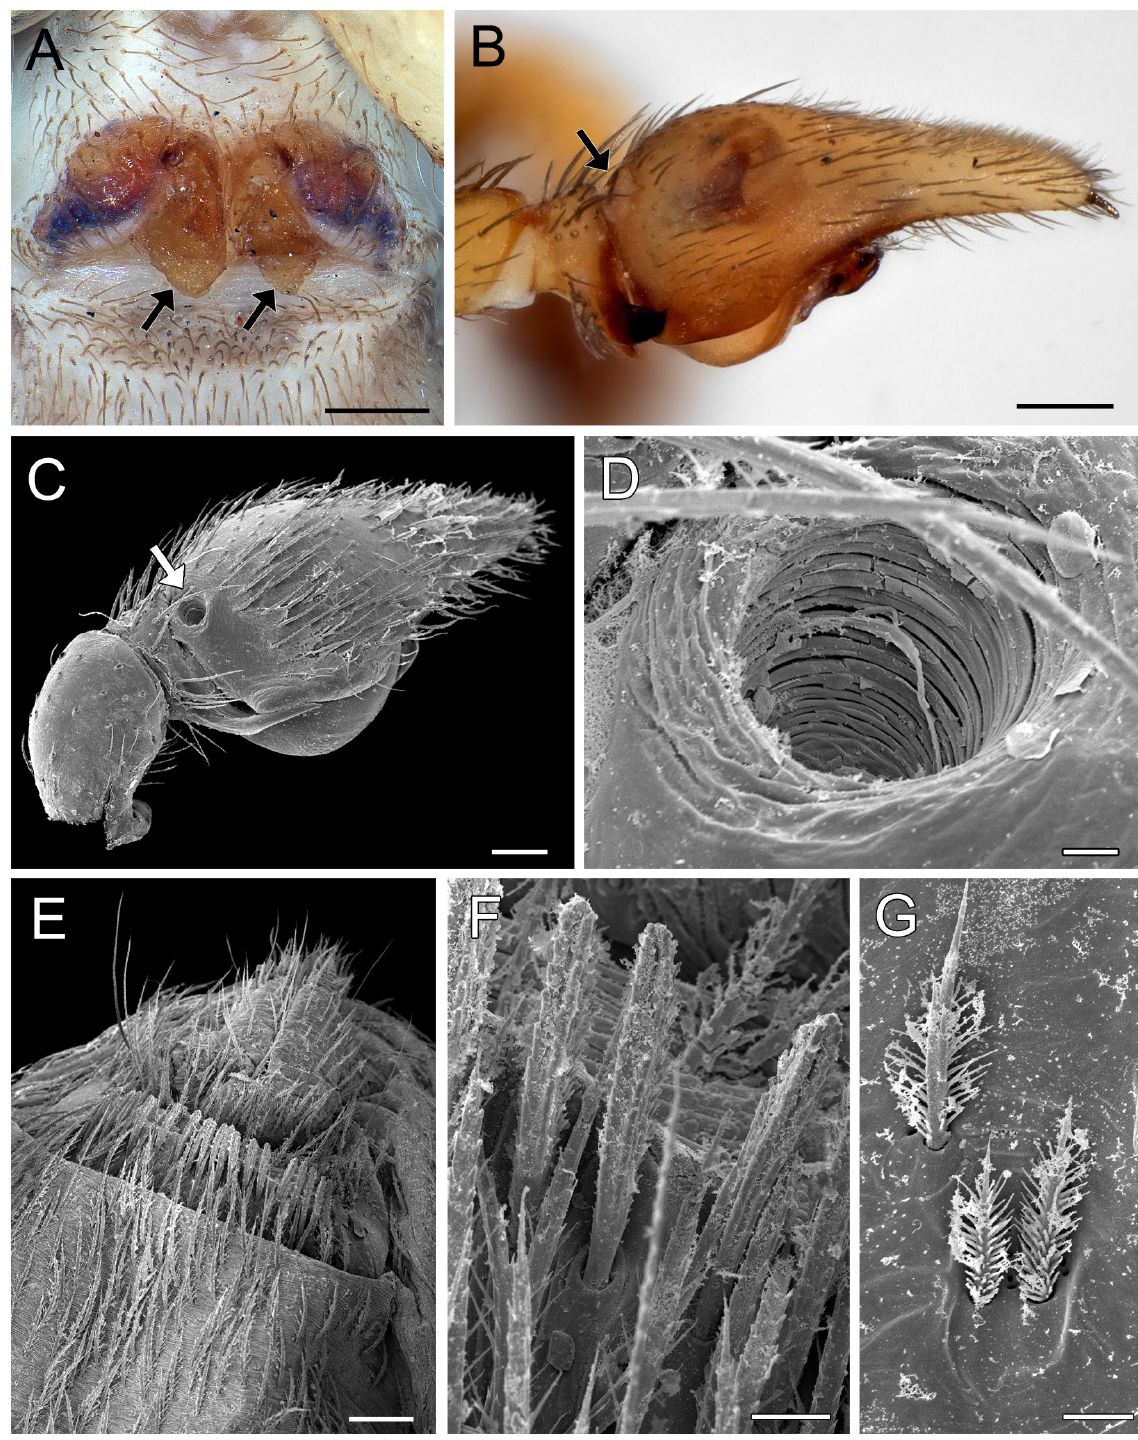
Fig. 12. A . Acanthinozodium tibesti Jocqué, 1991, holotype ♀ (MRAC 133011), epigyne, ventral view; arrows indicate both sides plugged. B . Acanthinozodium sahariense Denis, 1959 (CRB), male palp, dorsolateral view; arrow indicates the crater-like plug pit. C . Acanthinozodium sericeum Denis, 1956 (CRB), male palp, dorsolateral view; arrow shows the crater-like plug pit. D . Idem, detail of previous. E . Same specimen, abdomen, ventral view. F . Idem, detail of previous. G . Same specimen, femoral organ on leg II. Scale bars: A–B = 0.2 mm; C, E = 100 μm; F = 20 μm D, G = 10